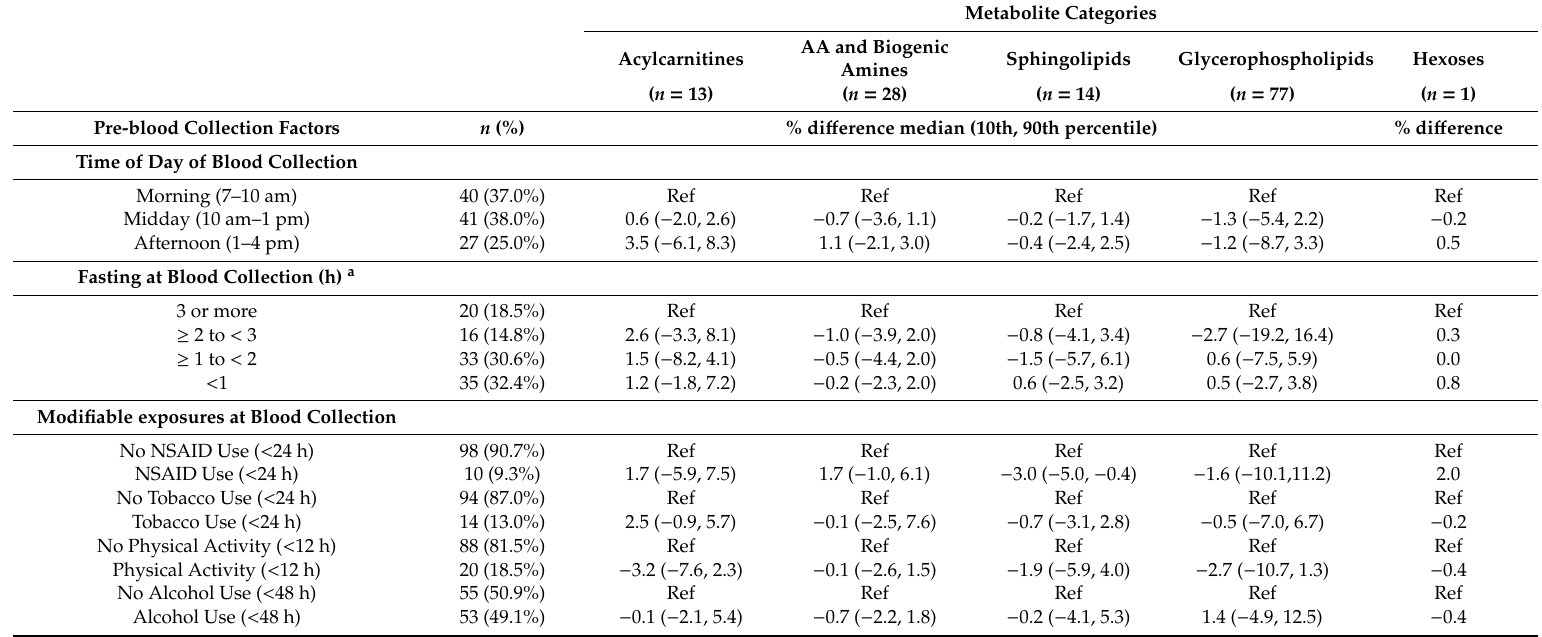
Table 4. Total number of metabolites within metabolite classes demonstrating statistically significant metabolite concentrations according to pre-blood collection factors in the PRÄVENT cohort ( n = 108) a .